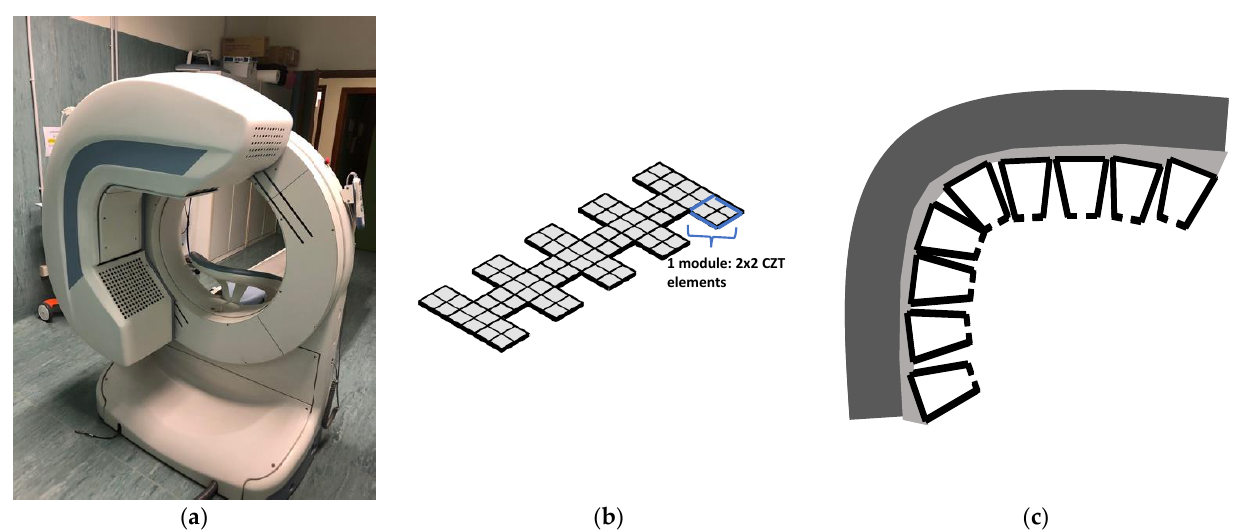
Figure 1. SPECT Alcyone. ( a ) the tomograph, ( b ) schematic representation of detectors configuration; ( c ) pin-holes collimators disposition.